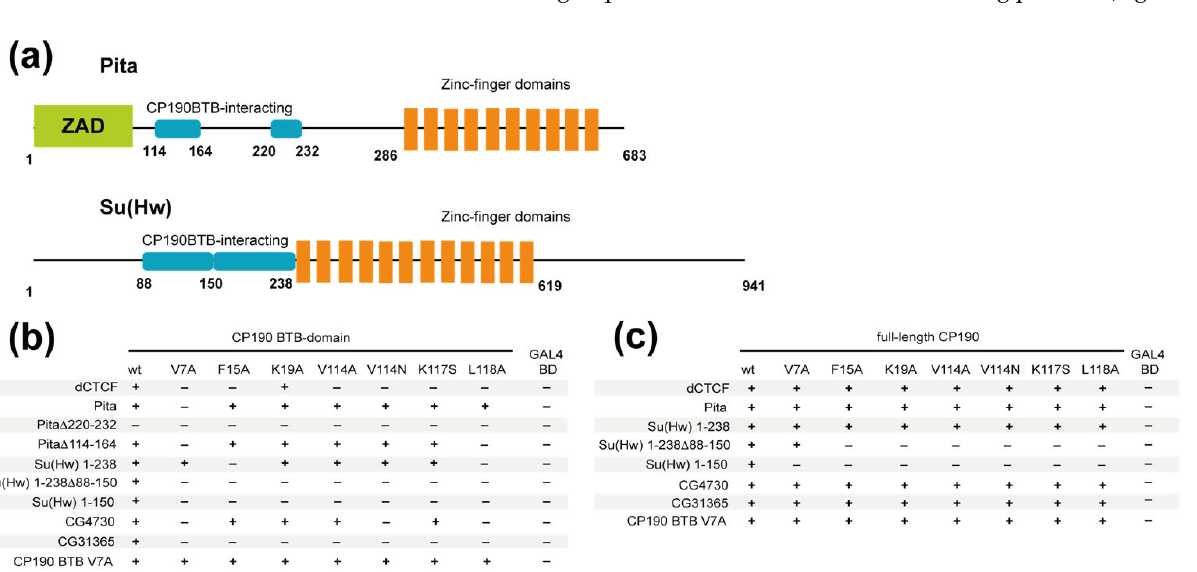
Figure 4. Testing of interactions between the C2H2 proteins and the mutant variants of the CP190 protein in a yeast two-hybrid assay. ( a ) Schematic representation of Pita and Su(Hw) domain structures with CP190 BTB domain-interacting regions depicted. ( b ) Interaction of the C2H2 proteins with CP190 BTB domains bearing single amino acid substitutions within the peptide-binding groove. ( c ) Interaction of the C2H2 proteins with full-length CP190 proteins bearing single amino acid substitutions within the BTB domain. CP190 BTB domain and full-length proteins were fused to the GAL4 DNA-binding domain (GAL4 BD); C2H2 proteins were fused with the GAL4 activation domain. The growth assay yeast plates are shown in the Supplementary Materials Figures S10 and